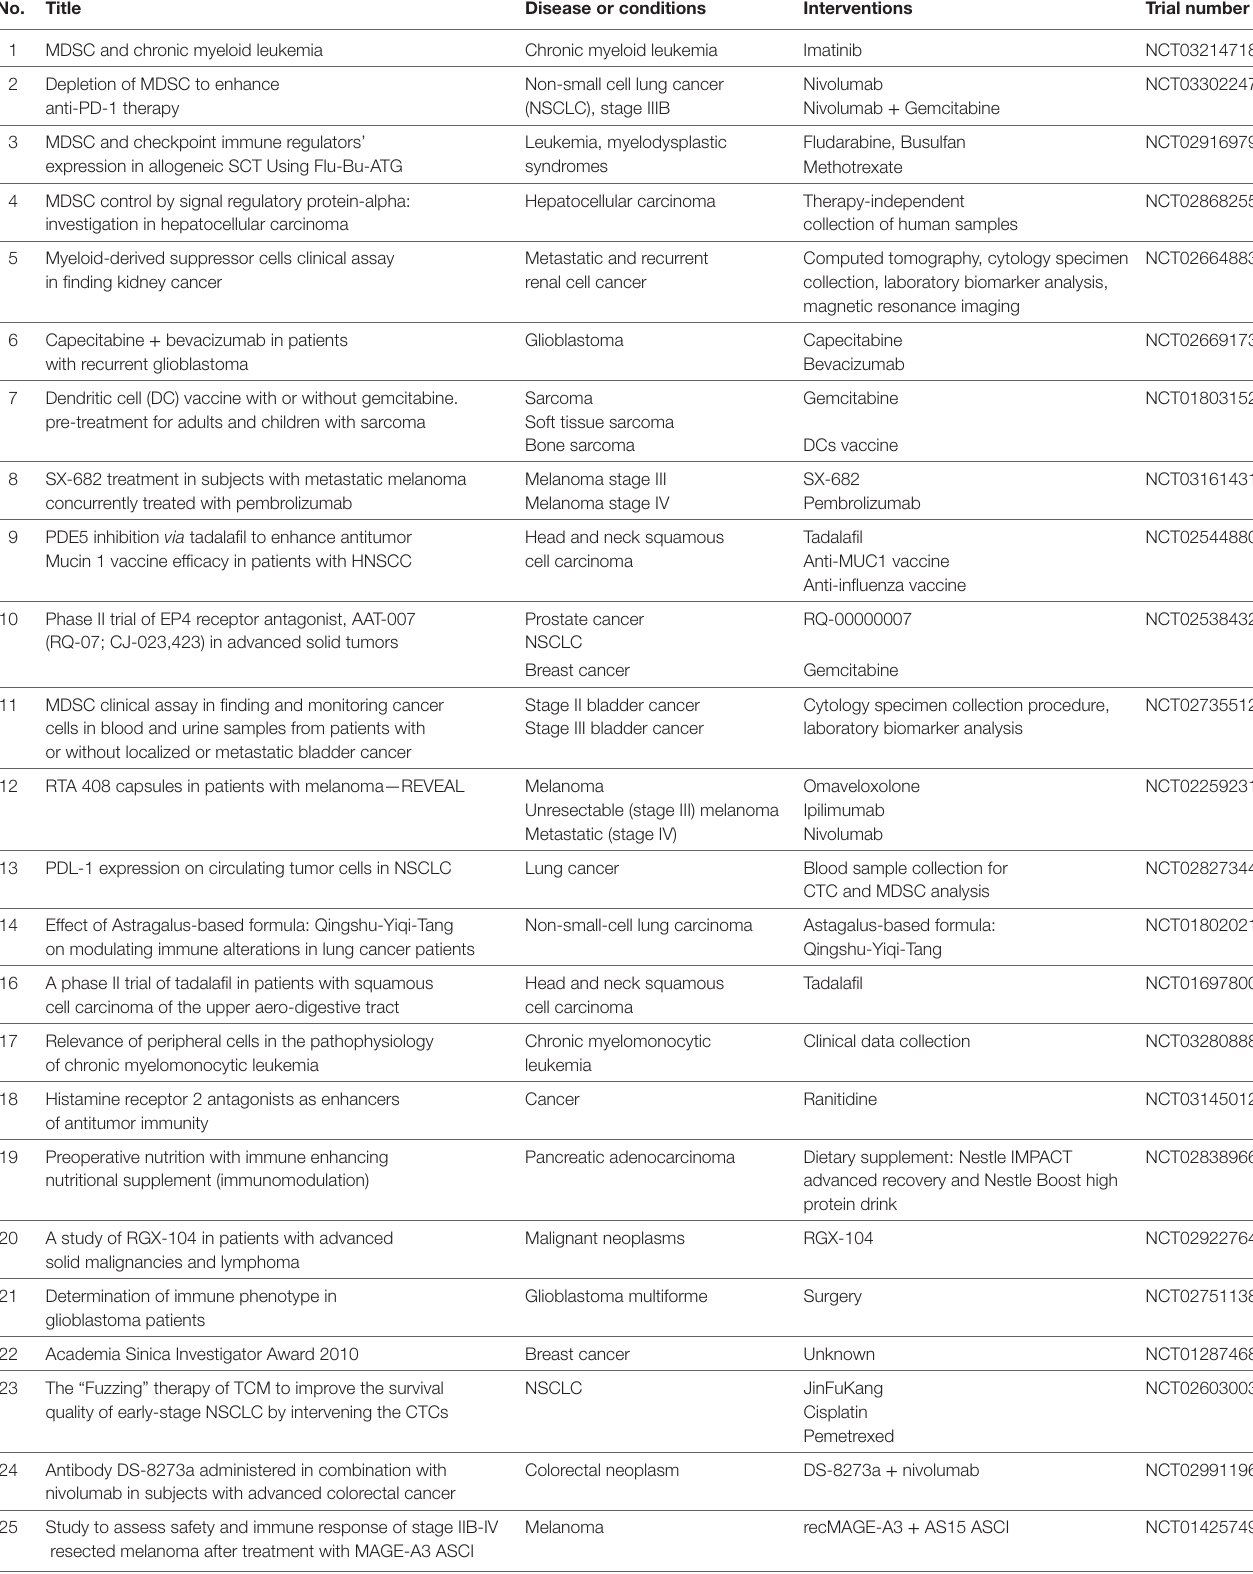
TABLe 1 | Ongoing clinical trials to target myeloid-derived suppressor cells (MDSC) in cancer